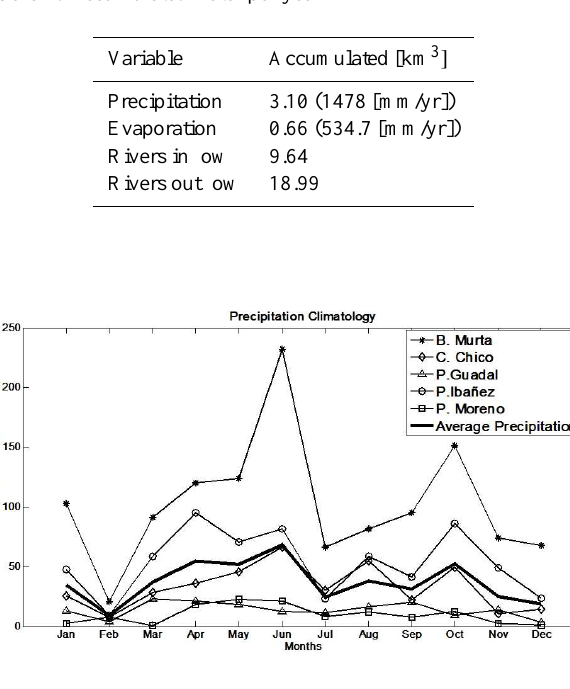
Monthly mean precipitation (accumulated mm/month) for the different in-situ meteorological stations and the averaged monthly mean precipitation over the lake.